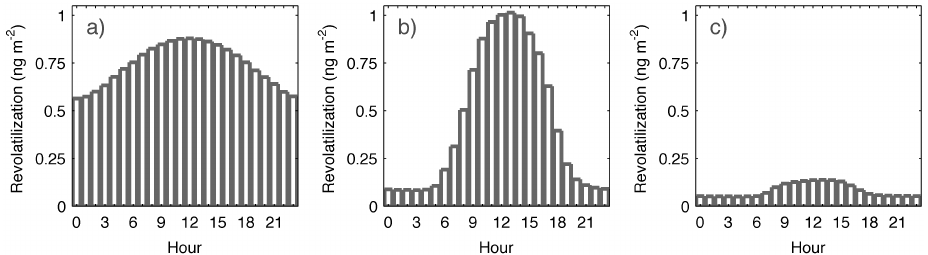
Fig. 5. Shown is the 5-yr (2005–2009) average from SORun of revolatilization of GEM from snowpacks as a function of the local hour at (a) Alert, (b) Kuujjuarapik and (c) Point